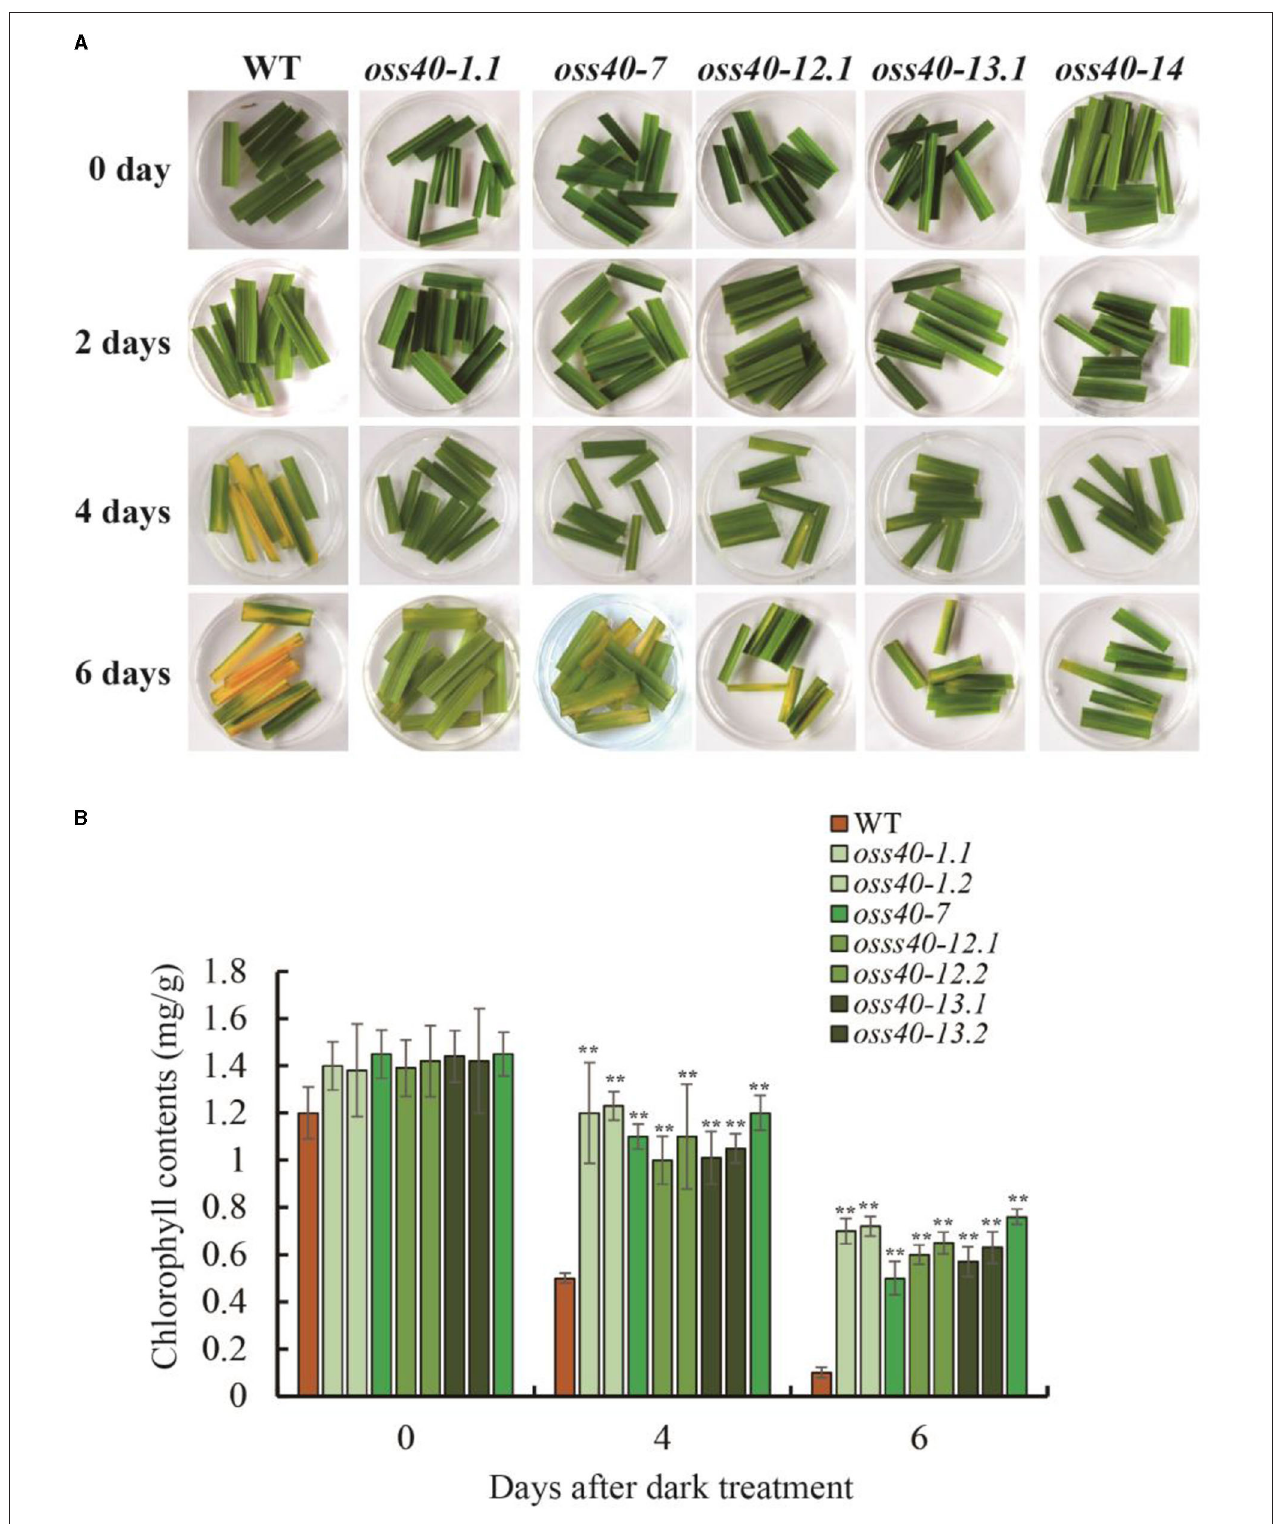
FIGURE 3 | The stay-green phenotype of the detached leaves of different oss40 mutant lines after darkness treatment. (A) The detached leaves from three plants represent the stay-green phenotype of oss40 ( − 1, − 7, − 12, − 13, and − 14) mutants relative to WT, respectively, at 0, 2, 4, 6 days after darkness treatment. (B) The total chlorophyll levels of WT and oss40 mutants at 0, 4, 6 days after darkness treatment, respectively. Ten pieces of detached leaves were used for chlorophyll extraction and content measurement. Mean and SD values were obtained from three biological replicates. Significant differences of the chlorophyll levels normalized to WT were evaluated using Student’s t -test (** p <